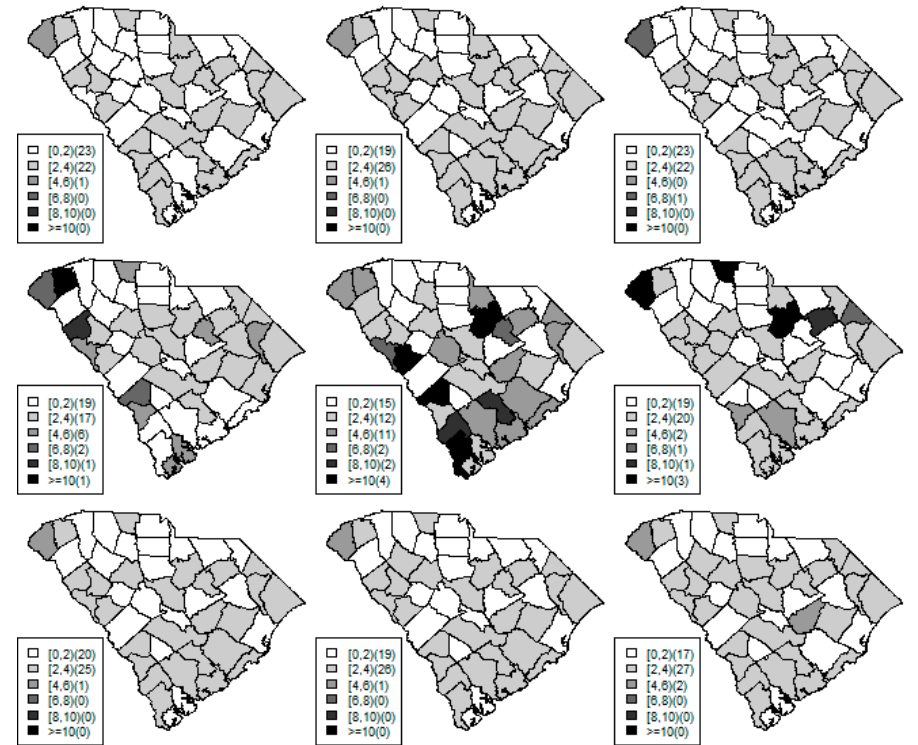
Figure 2. Maps of the estimated median quantile relative risks from the proposed quantile ( top row) and mean ( middle row) regression models versus the simulated relative risks ( bottom row) during years 2 (left) to 4 (right).